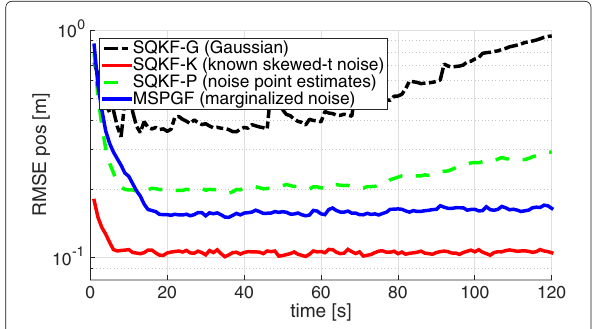
Fig. 1 Filtering RMSE of position with ν =